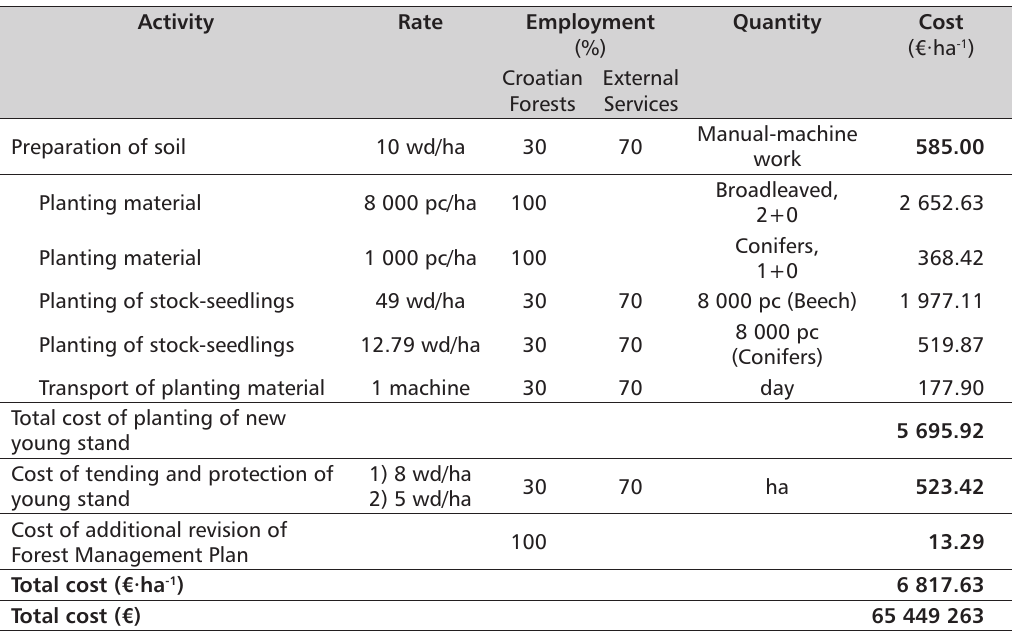
TABLE 4. Total cost of recovery for destroyed stands – identified priority areas encompass 9 600 ha